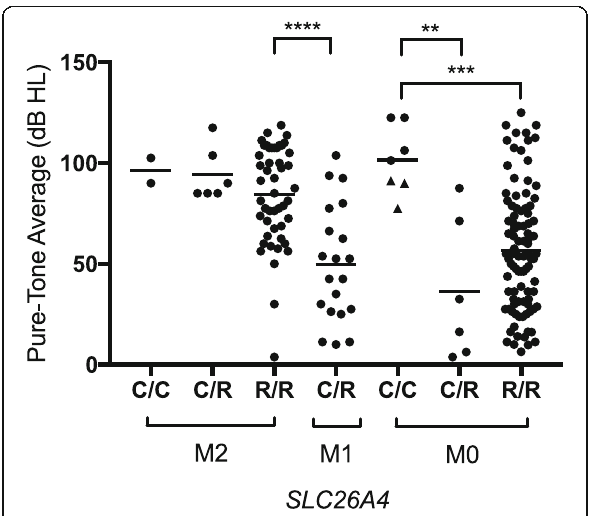
Fig. 1 Four-frequency (0.5/1/2/4 KHz) pure-tone threshold averages for ears with enlargement of the vestibular aqueduct. Each data point represents one ear displayed according to SLC26A4 genotype status (M0, M1 or M2) and haplotype status (C, CEVA; R, reference (most common haplotype)). The CEVA haplotype is trans to the